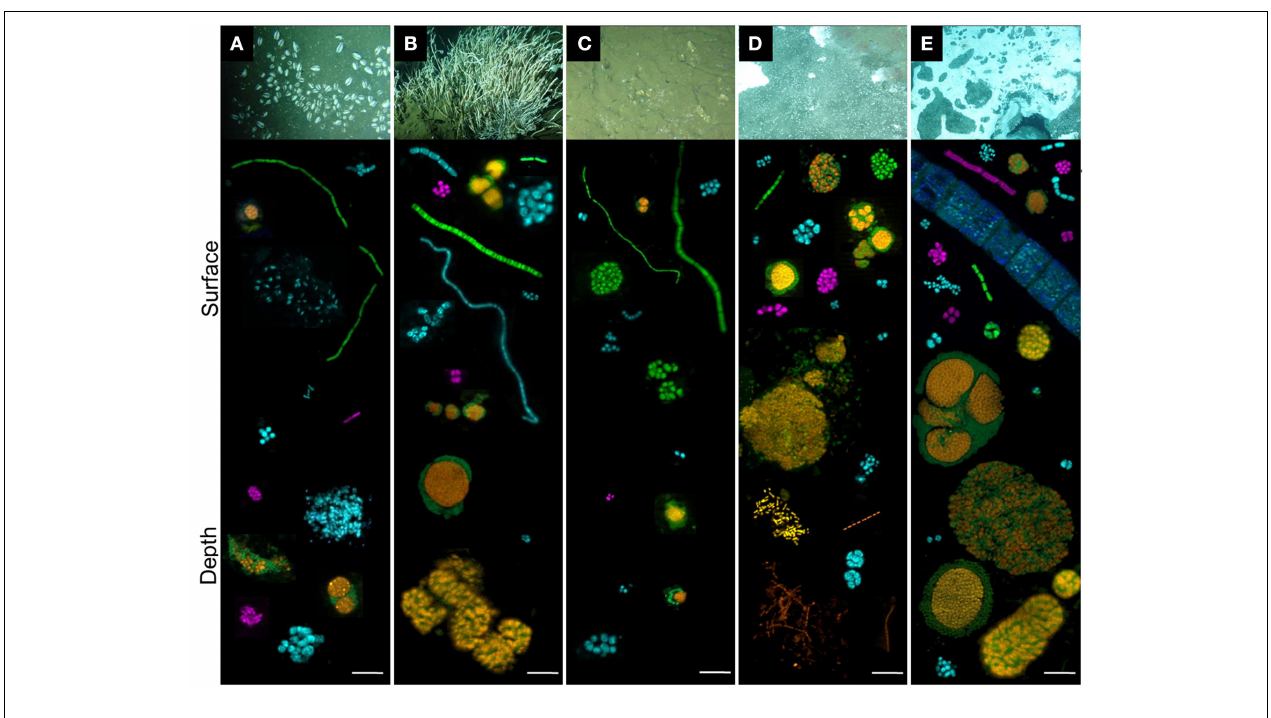
FIGURE 6 | Individual cells and cell aggregates of ANME (orange), Deltaproteobacteria (green), Gammaproteobacteria (blue) and Epsilonproteobacteria (purple) visualized with fluorescent-labeled oligonucleotide probes. Each aggregate, single cell or heaps were taken